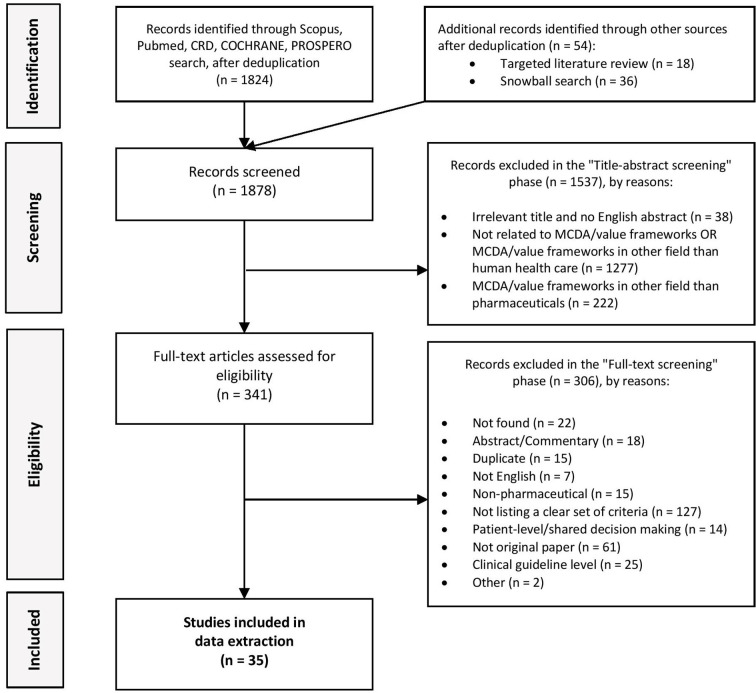
PRISMA flow diagram.